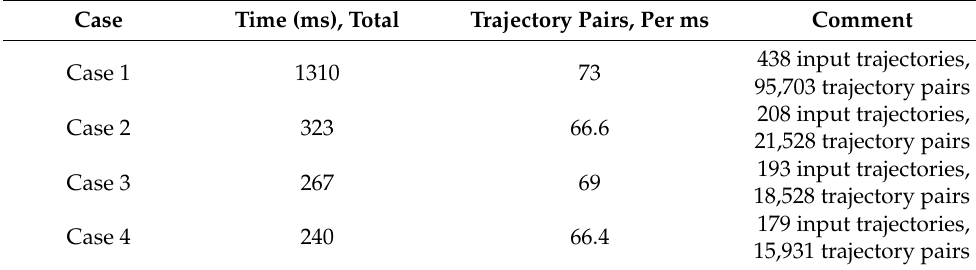
Table 4. Trajectory